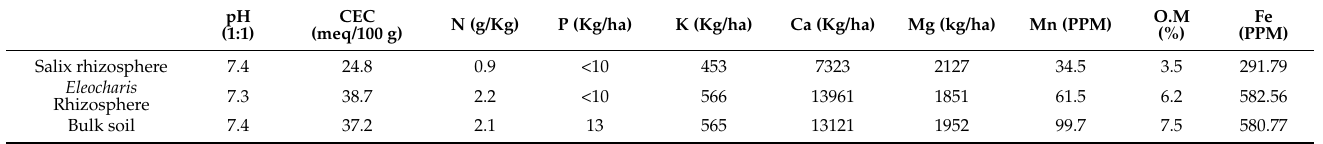
Table 3. Chemical and physical characteristics of soils used in this